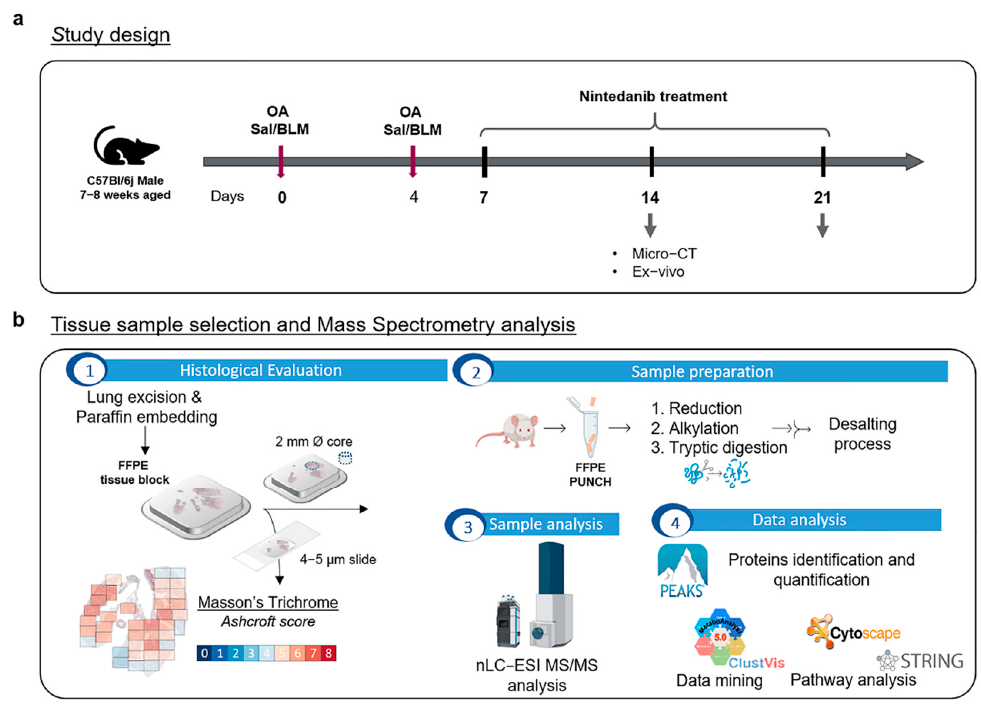
Figure 7. Experimental workflow of all the processes involved in sample collection, preparation, and data analysis. ( a ) Study design for control, BLM, and NINT treatment groups in C57BL6 mice. ( b ) Tissue sample selection and mass spectrometry analysis: (1) lung tissue histological evaluation, (2) sample preparation, (3) sample analysis, and (4) data analysis. BLM—bleomycin; OA—oropharyngeal aspiration; NINT—nintedanib; CT—computed tomography;